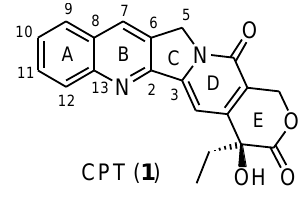
Figure 1. Structure of CPT, 1 .